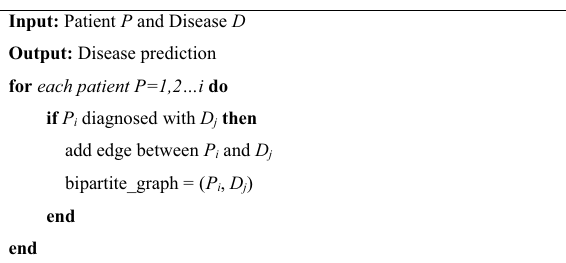
Algorithm 1 . Pseudo-code for GNN-based